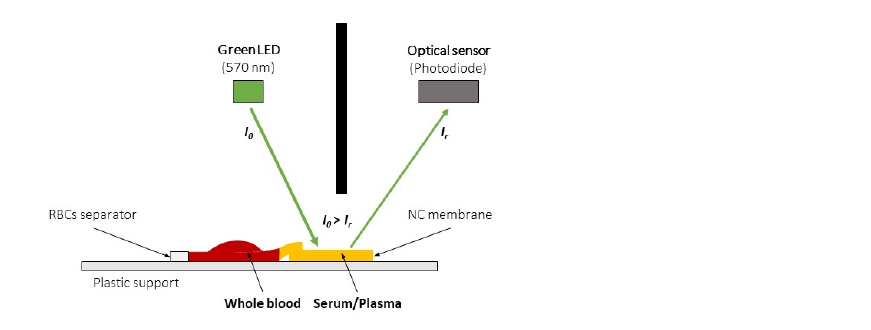
Figure 1. The optical measurement system. The LED light source irradiates the membrane filled with plasma forming the sample; an optical sensor positioned in the same chamber measures the amount of reflected light, enabling the calculus of sample absorbance.